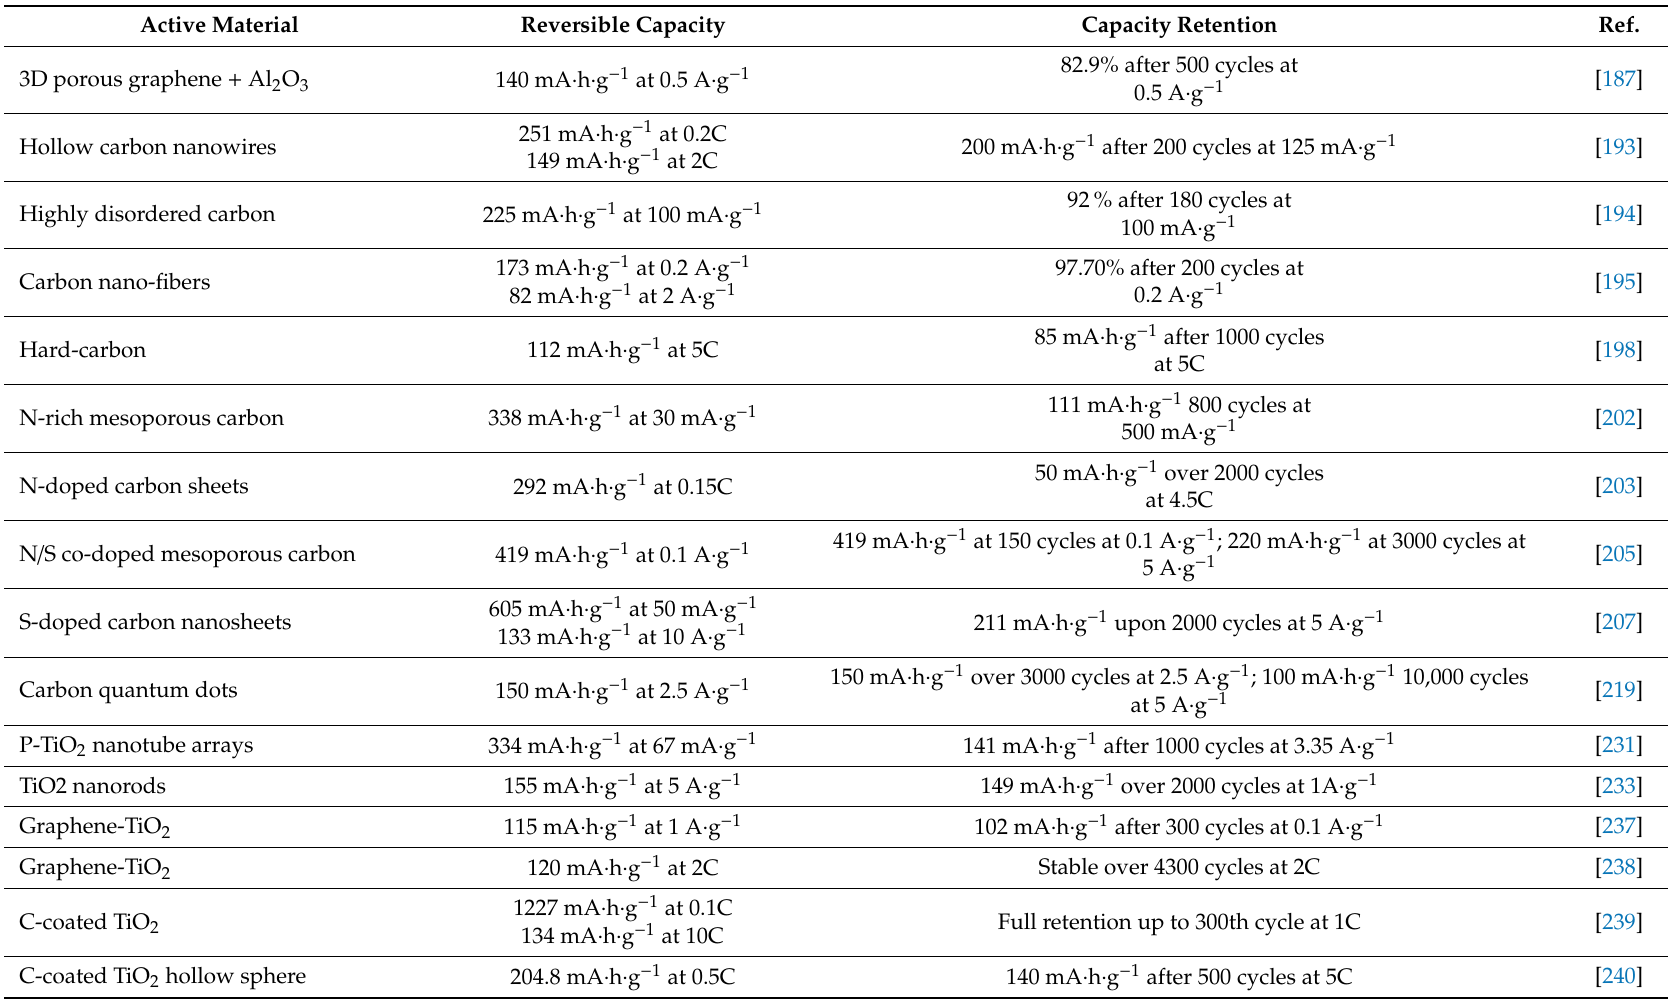
Table 2. Electrochemical properties of selected anode materials reviewed in the text: carbon-based anodes (from ref. [187–219]), metal chalcogenide-based including intercalation materials (from ref. [231–245]) and conversion reaction compounds (from ref.